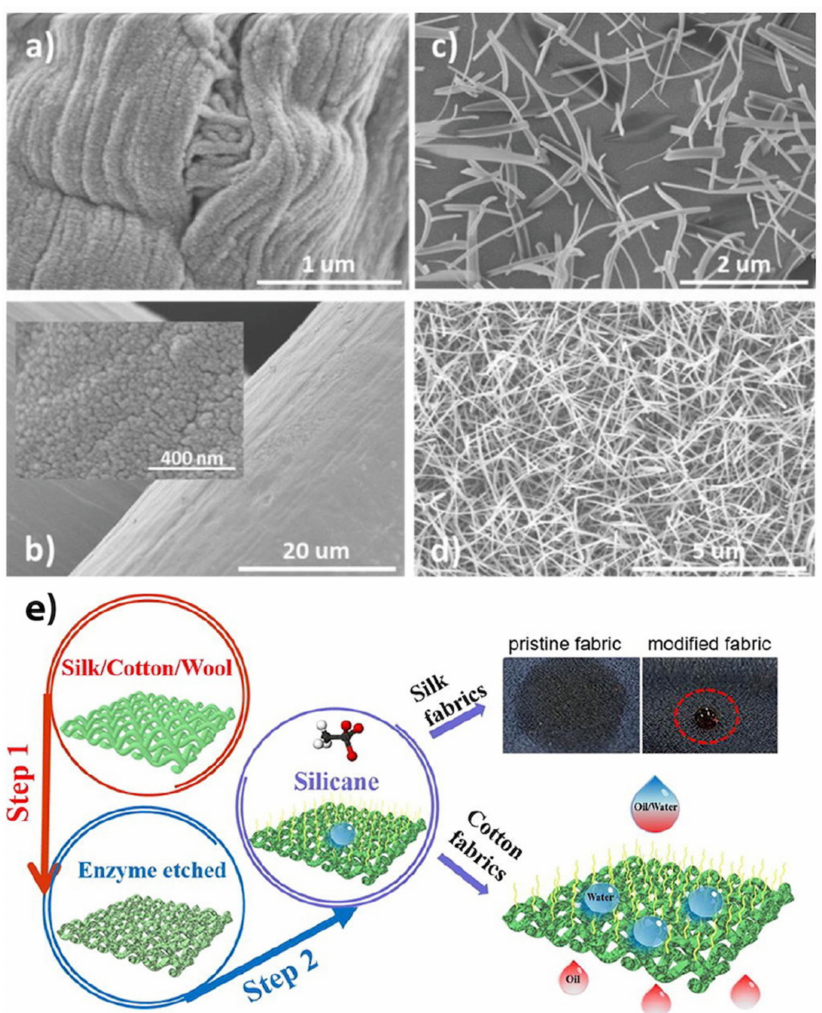
Figure 15. SEM images of ( a ) cellulose filter, and ( b ) SS membrane after the first PECVD to form TiO 2 nanofibers as the nucleation layer (step 1); ( c , d ) Top view SEM images of H 2 Pc nanowires created on TiO 2 nucleation layer under the growth rate of <0.5 Ås − 1 and >1.5 Ås − 1 , respectively. (Reproduced from [102] with permission from John Wiley and Sons). ( e ) The enzyme etched fabric is silanized via CVD to reduce the surface energy for oil/water separation application. (Reprinted from [105] with permission from